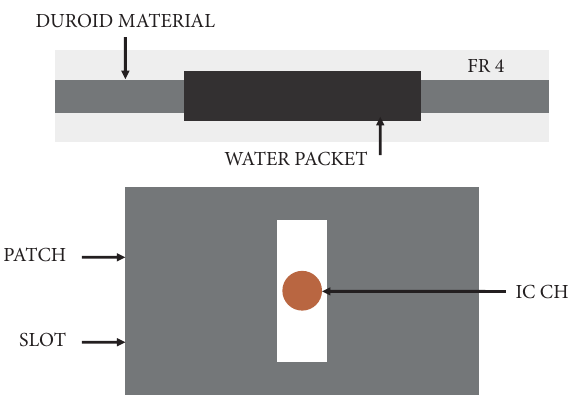
Figure 4: Structure of the HDPE-BST sensing antenna.